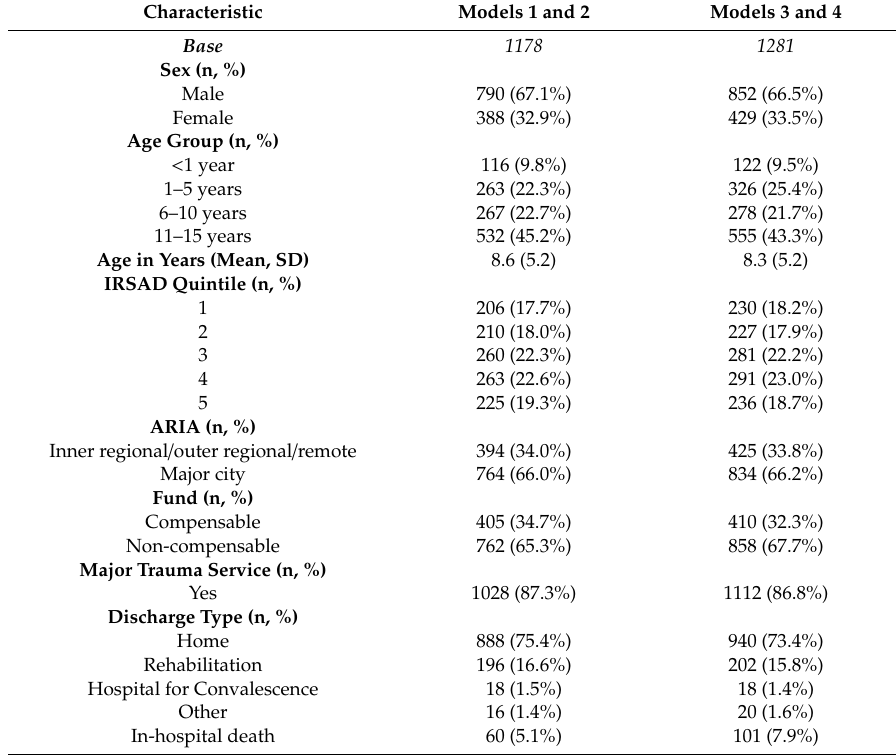
Table 1. Patient demographic characteristics.